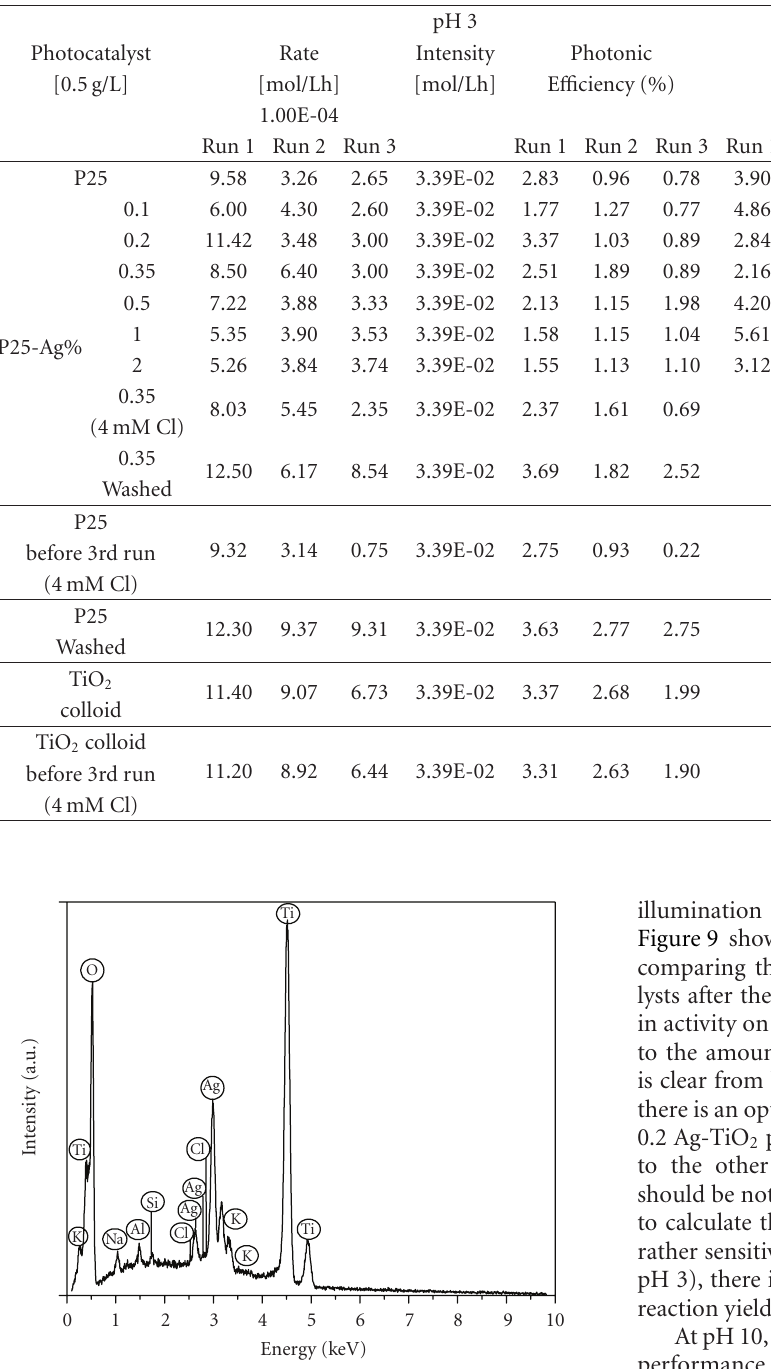
Figure 12: EDXS spectrum of 0.2 Ag-TiO 2 photocatalyst after photodegradation of DCA in three consecutive